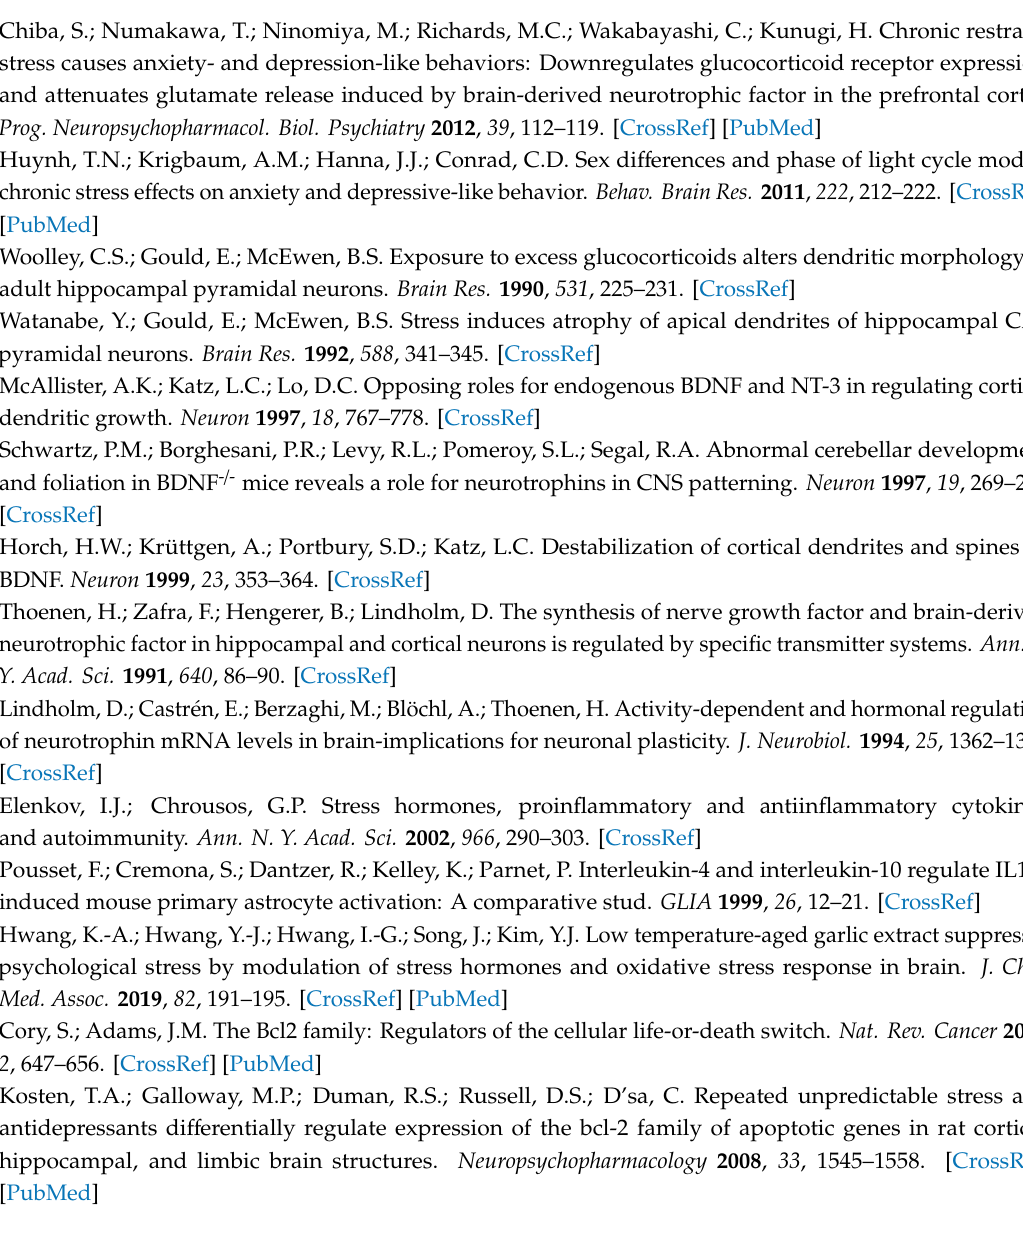
Figure S1: E ff ect of ML extract on blood glucose